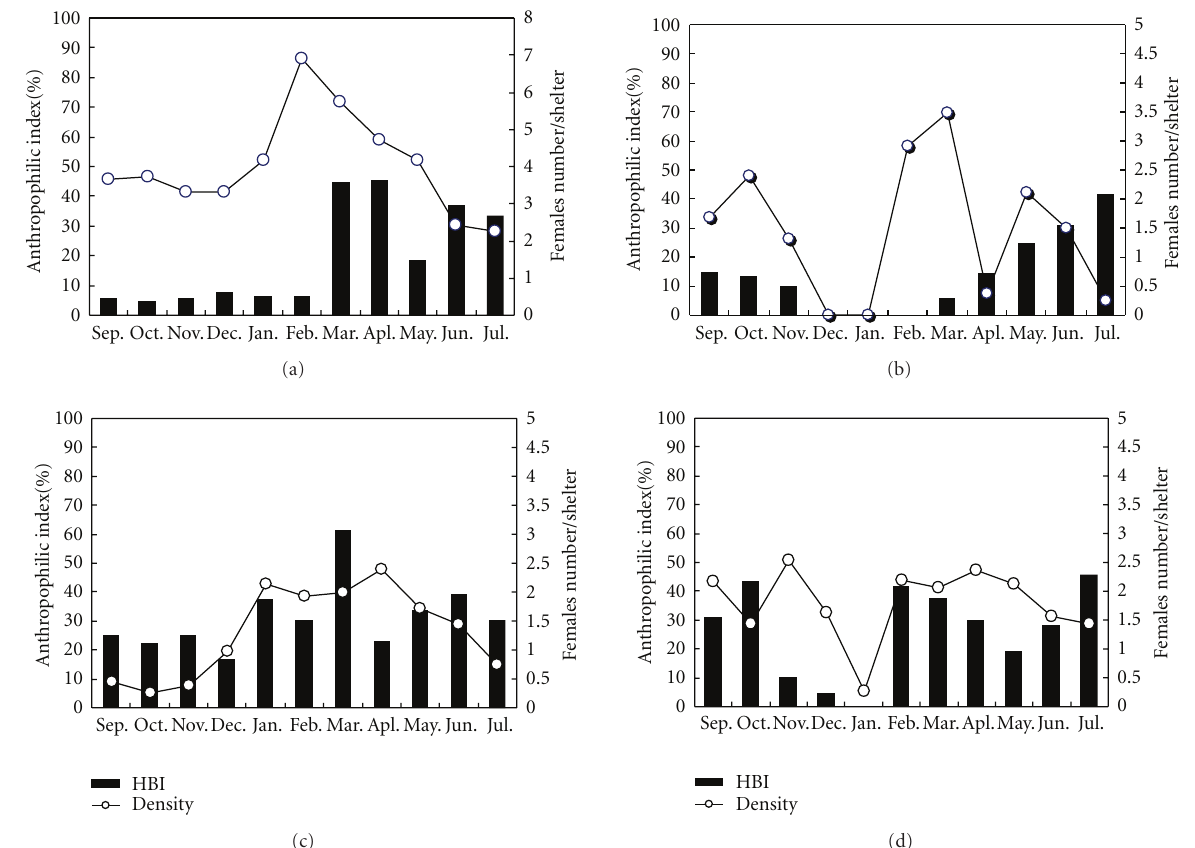
Figure 2: Seasonal anthropophilic index and activities females of four Anopheles vectors in a malaria endemic area in south and southeast of Iran. (a) Anopheles stephensi. (b) Anopheles culicifacies. (c) Anopheles fluviatilis . (d) Anopheles